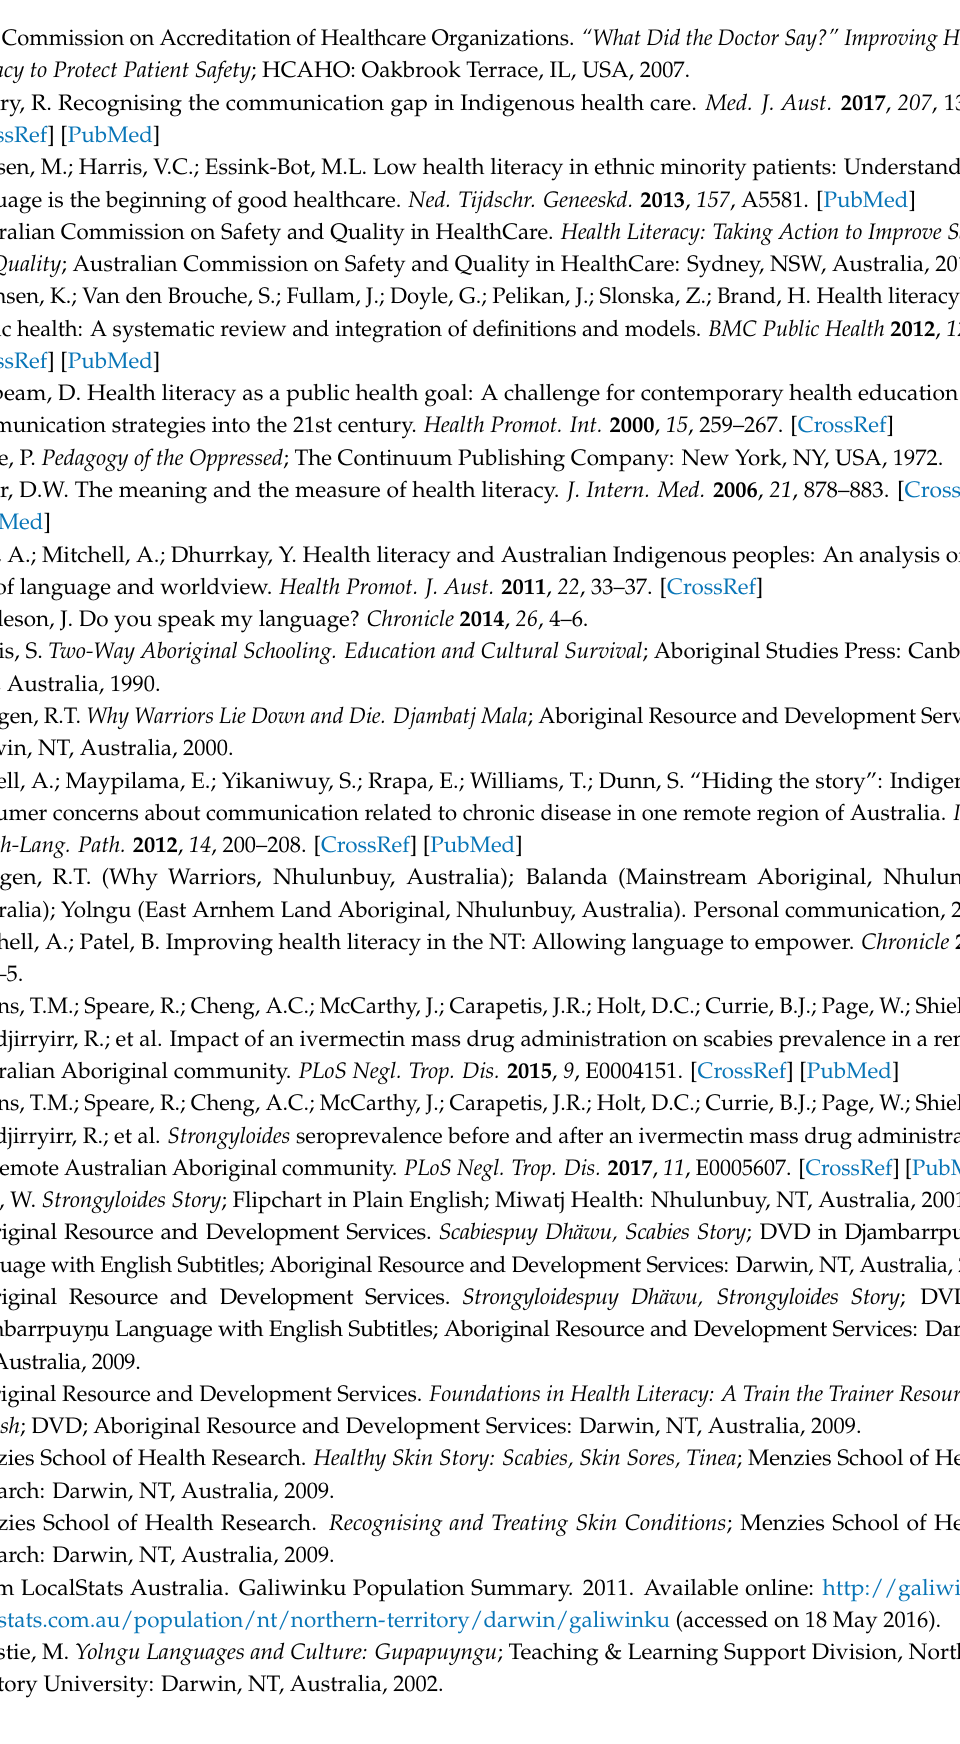
Table 1. Principles of Discovery Education (Modified from Trudgen [14] (pp. 202–210).